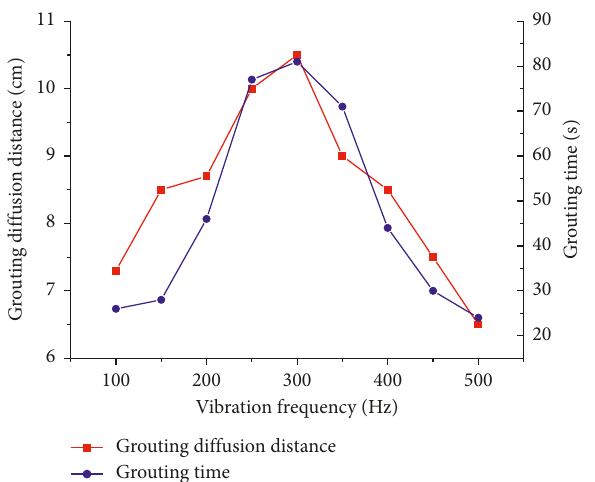
Figure 8: Variation of grout diffusion radius under different vi- bration frequencies.